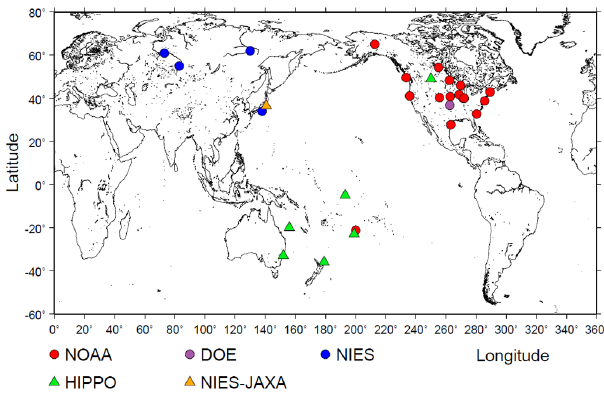
Figure 1. Global distribution of the aircraft measurement sites used for GOSAT